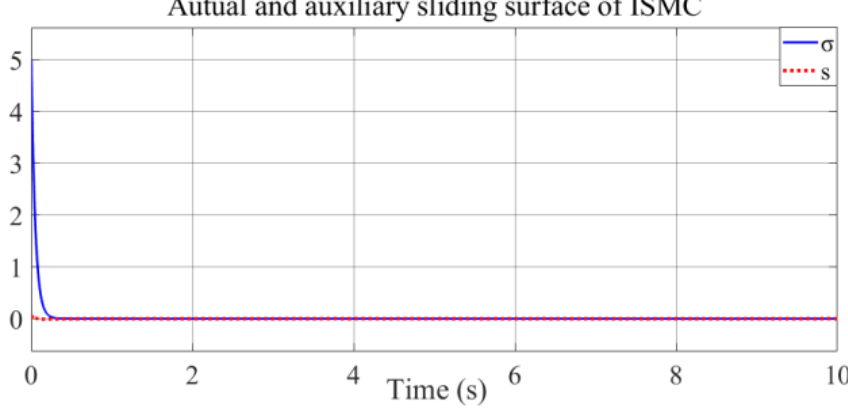
shows the control output of both forms of implemented logic.